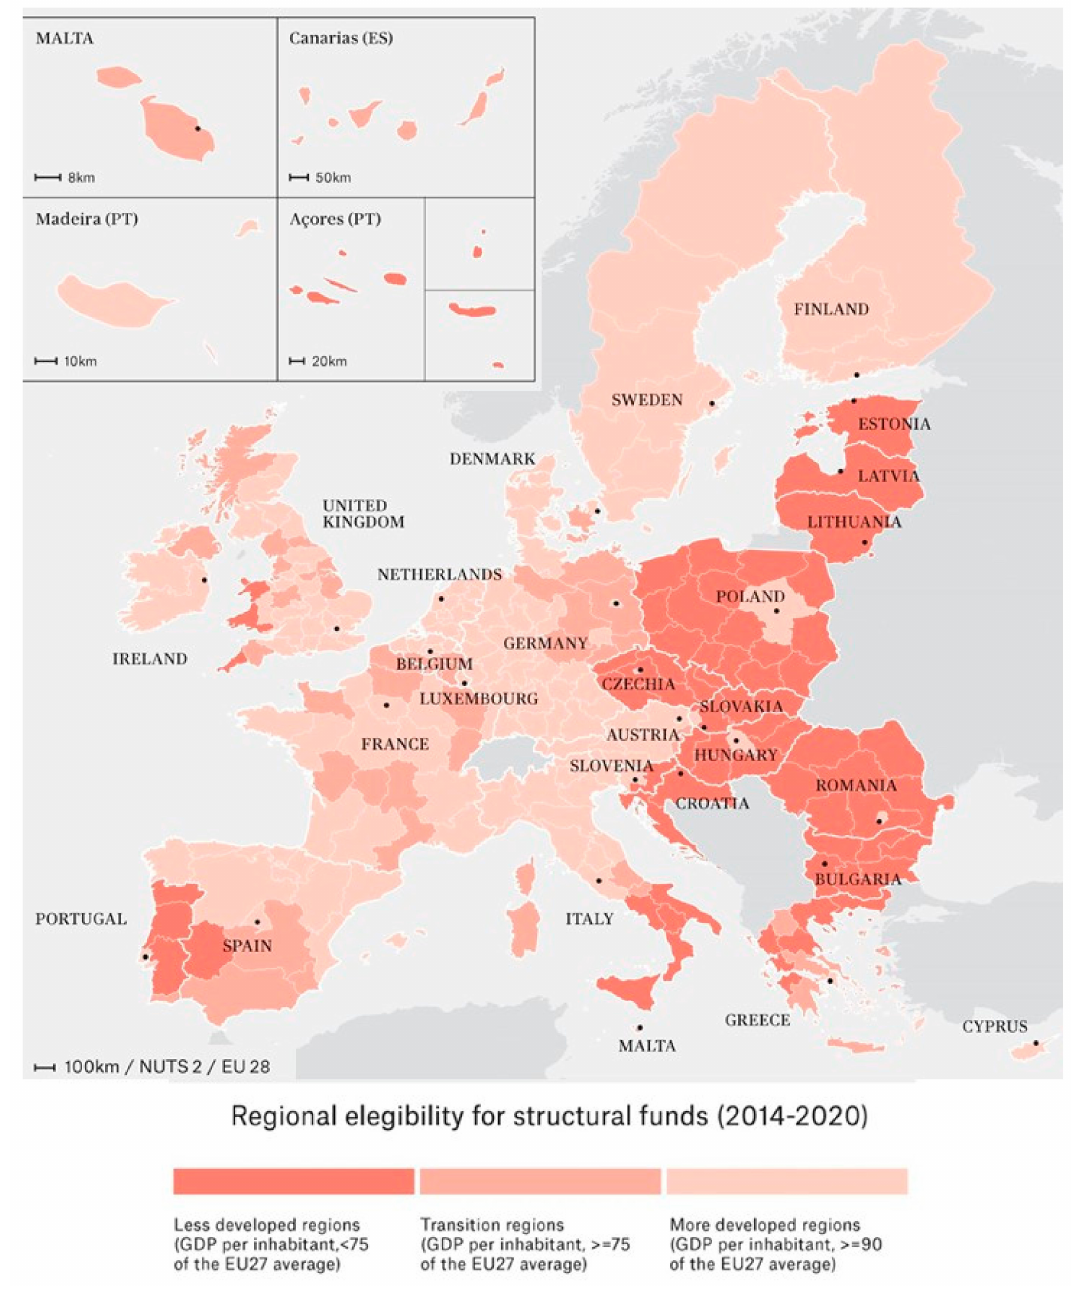
Figure 1. Regional eligibility map,